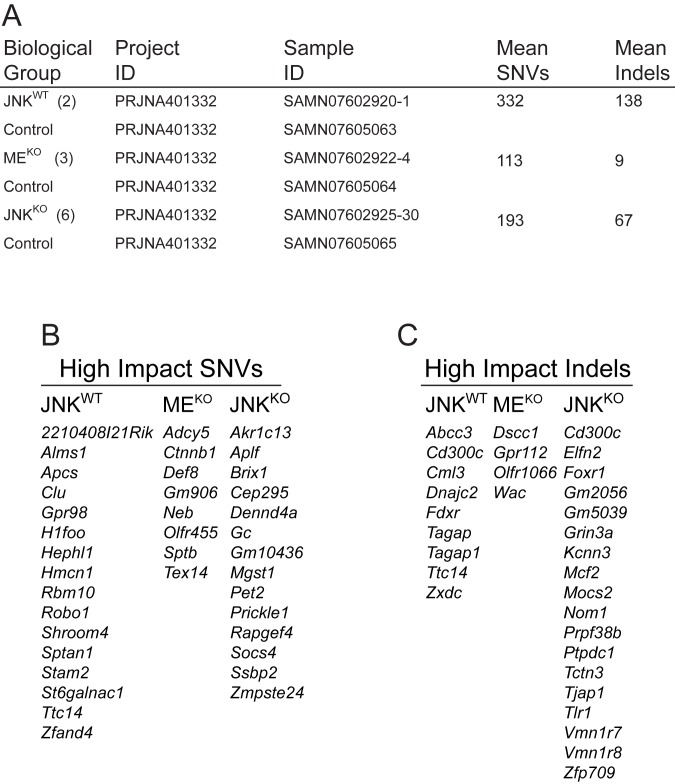
Summary of exome sequence data.(A) Nomenclature Key: JNKWT (tumors from parous Wap-Cre+/- Mapk8+/+ Mapk9+/+ Trp53LoxP/LoxP mice); JNKKO (tumors from parous Wap-Cre+/- Mapk8LoxP/LoxP Mapk9LoxP/LoxP Trp53LoxP/LoxP mice); MEKO (tumors from parous Wap-Cre+/- Mapk8LoxP/LoxP Mapk9LoxP/LoxP mice); and Control (mammary epithelium of non-parous mice of the same genotype). The NCBI SRA accession information (Project ID and Sample ID) for the exome sequence data is presented. The mean number of single nucleotide variants (SNVs) and insertions/deletions (Indels) is shown for each tumor genotype. An examination of frequent nucleotide changes revealed that MEKO tumor cells favored G to A (2/3 tumor cell lines) and JNKKO favored C to T (4/6 tumor cell lines) replacements, but no favored replacements were identified in JNKWT tumor cells. (B, C) High impact SNVs (B) and Indels (C) identified in JNKWT (n = 2), MEKO (n = 3) and JNKKO (n = 6) cells are summarized. No well-established driver mutations were found among the high impact indels or SNVs identified and there were no recurring mutations within or across genotypes.